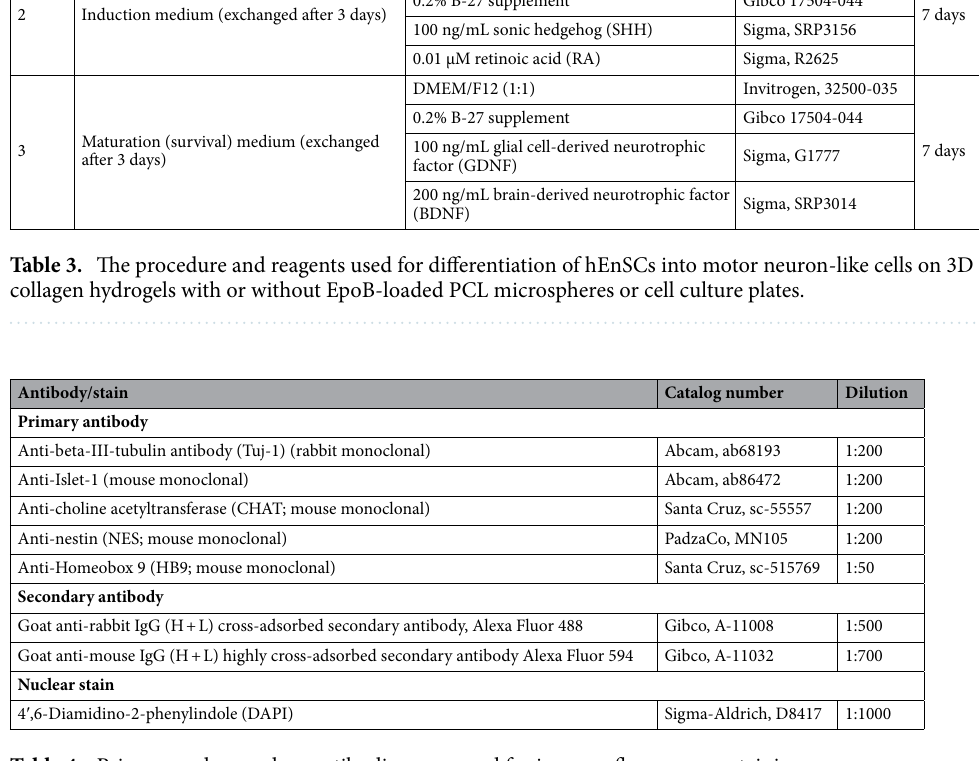
Table 4. Primary and secondary antibodies were used for immunofluorescence staining.